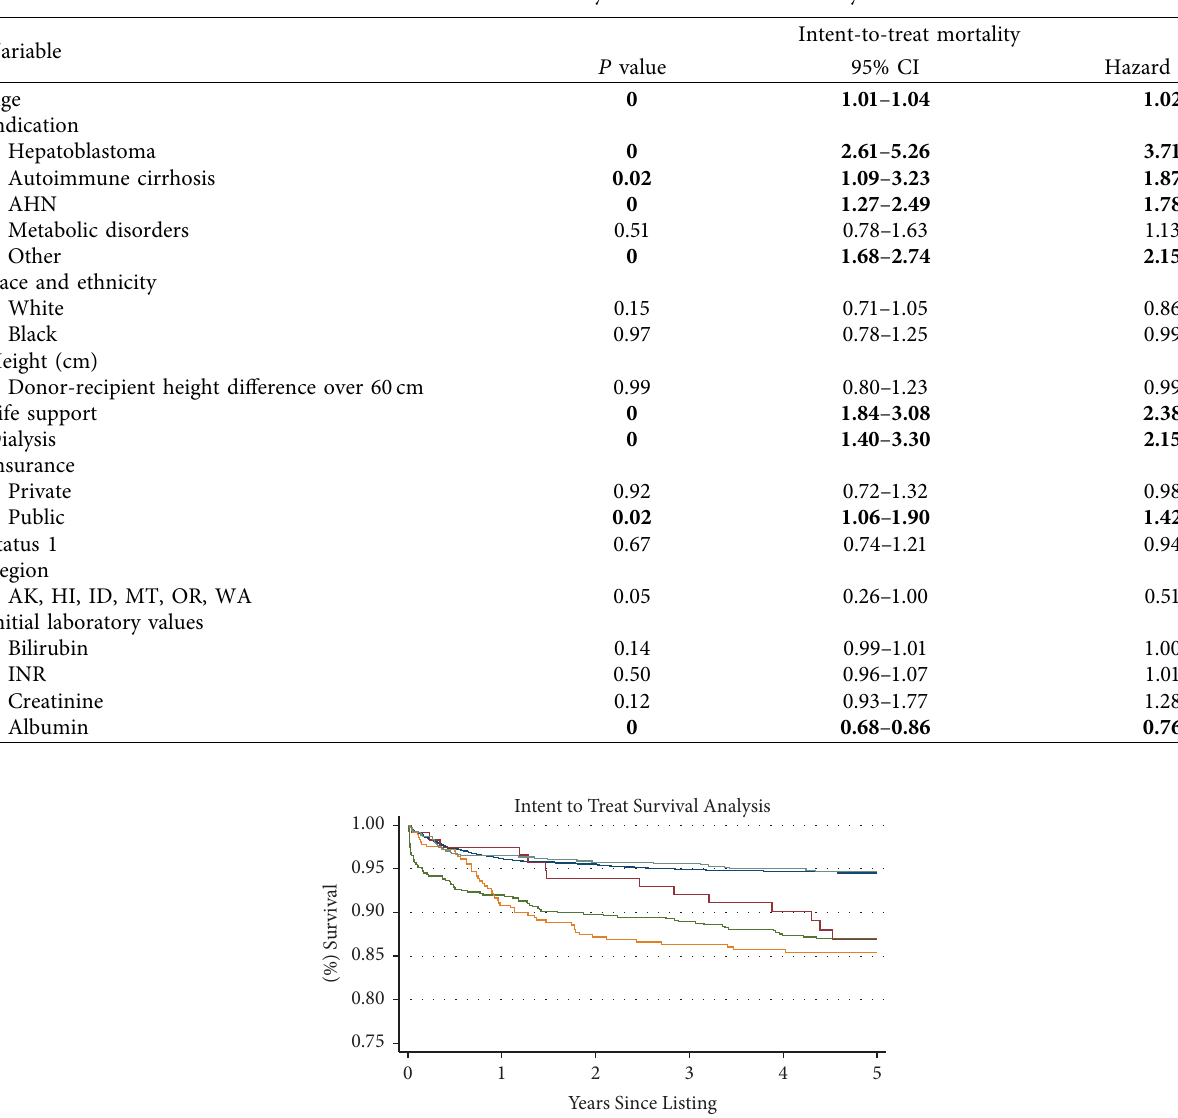
Table 3: Multivariable analysis: intent-to-treat mortality.